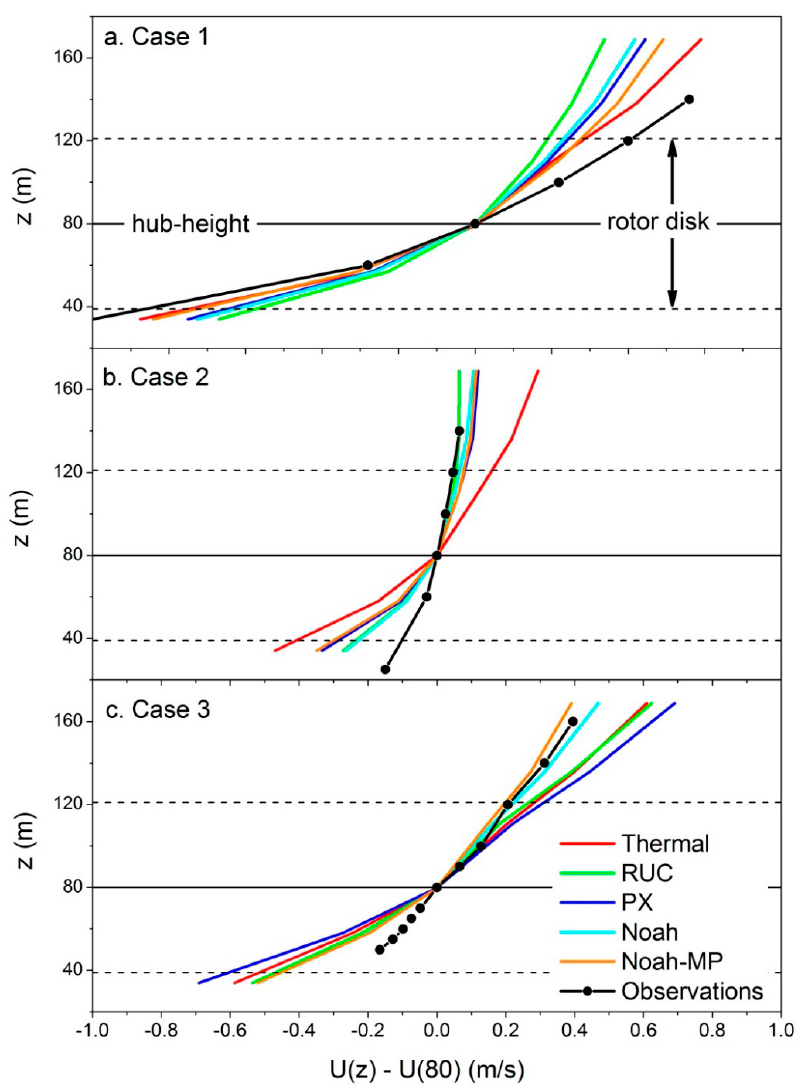
Figure 8. Mean midday wind speed profiles during (a) Case 1, (b) Case 2, and (c) Case 3 for each LSM in comparison to the observations shown in black. The four Noah-MP runs are shown as a group average. The wind speeds are plotted as the difference between the wind speed at height (z) and the wind speed at 80 m (wind turbine hub-height). Blades on nearby turbines span from 40 to 120 m in the atmosphere. Differences in shear profiles represent differences in the mean wind speed across a turbine